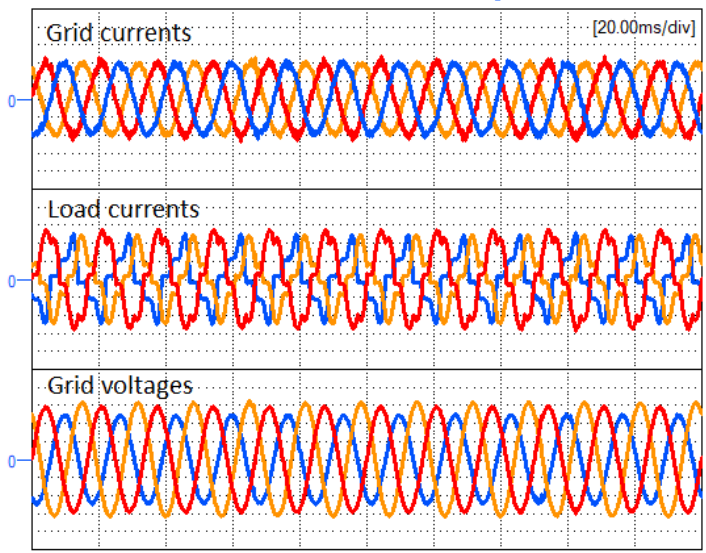
Figure 9. From top to bottom: grid currents (5 A/div), load currents (5 A/div) and grid voltages (50 V/div) under unbalanced grid